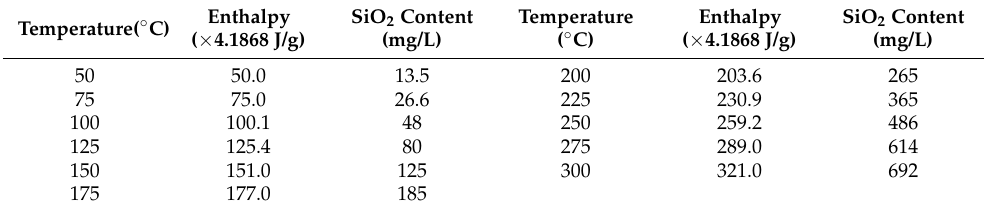
Table 5. Relationship between hot water temperature, enthalpy and SiO 2 content. Temperature( ◦